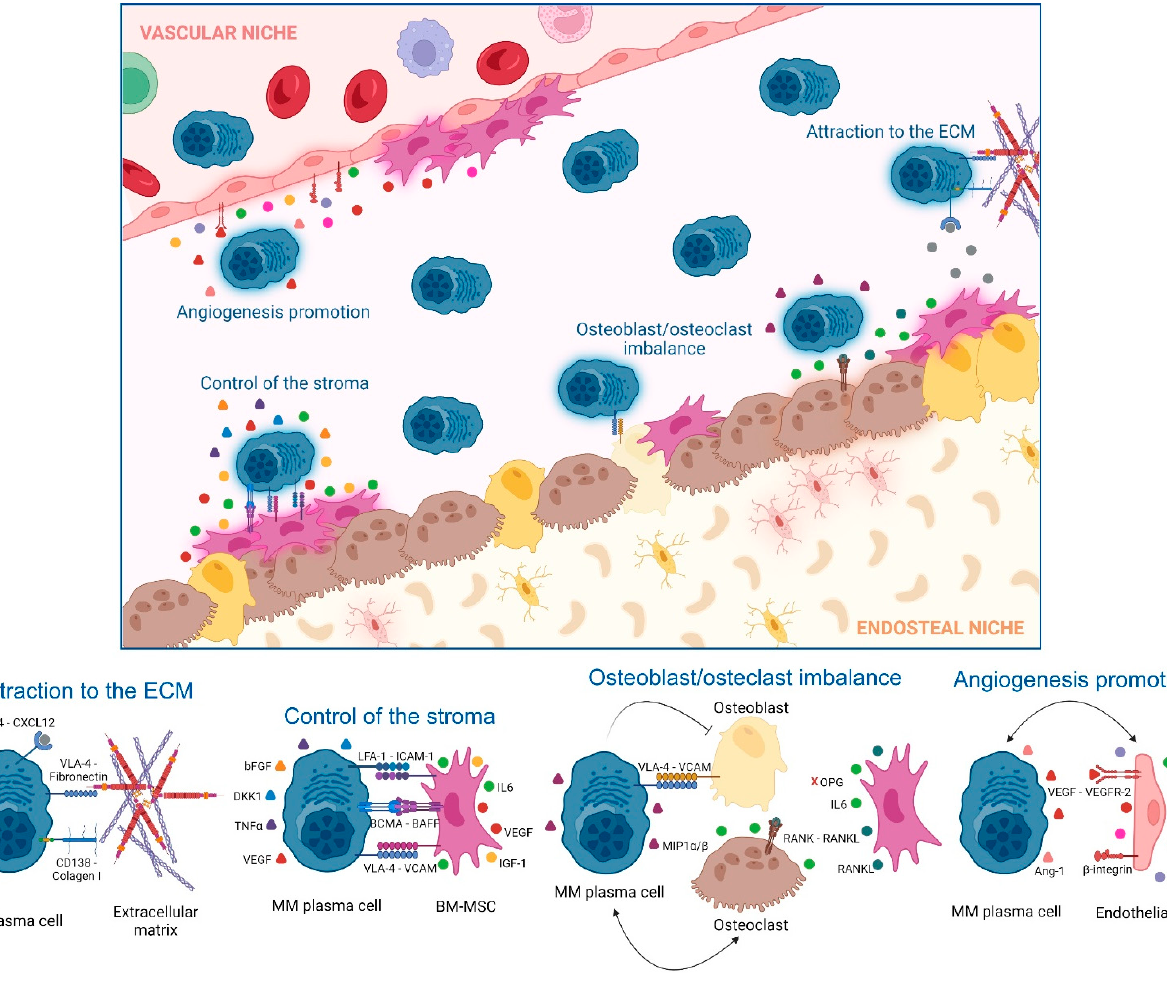
Figure 1. Summary of the interactions between non-hematological cells and multiple myeloma (MM) cells in the bone marrow (BM) : Different cell populations interacting with MM, receptors involved and secreted molecules by the different cell subsets that impact MM cell proliferation are indicated. The extracellular matrix (ECM) causes an attraction of MM cells to the BM. Bone marrow mesenchymal stromal cells (BM ‐ MSCs) and MM cells interact, making the stroma a favorable environment for MM cells. MM cells and BM ‐ MSCs alter the balance between osteoblast formation and osteoclast degradation. Endothelial cells enhance the angiogenesis in the BM to favor extramedullary disease. Table 1. MM the cell–cell interactions and molecules involved in the interactions that may affect disease progression and the anti ‐ MM therapies that could target these interactions.